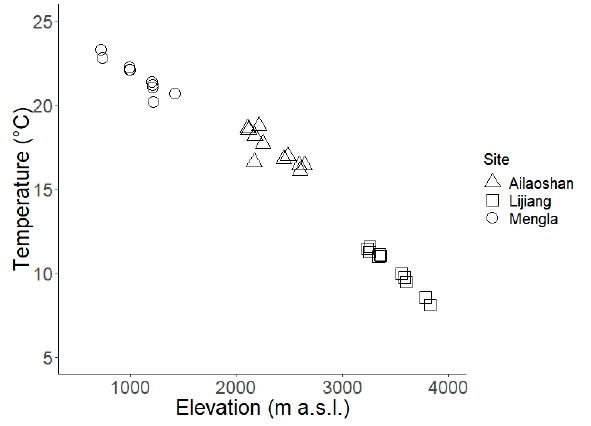
Figure 1. Mean daily understory temperatures from July to September 2015. Temperature data were recorded from each plot every two